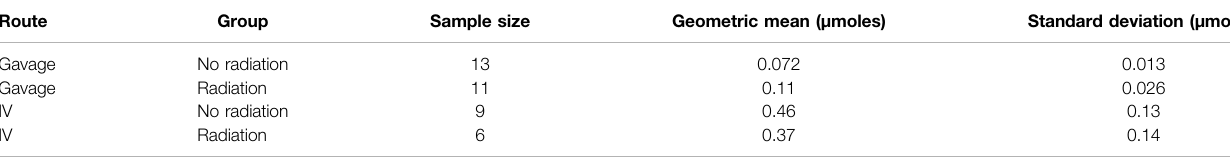
TABLE 4 | Measured lisinopril excreted in urine per 300 µg administered (µmoles).